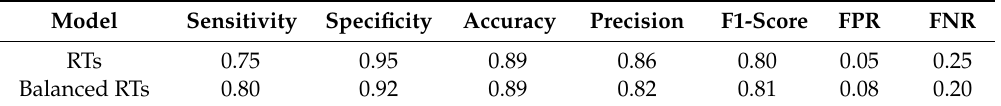
Table 3. Experimental results of conventional random trees (RTs) and balanced RTs classification models for the test